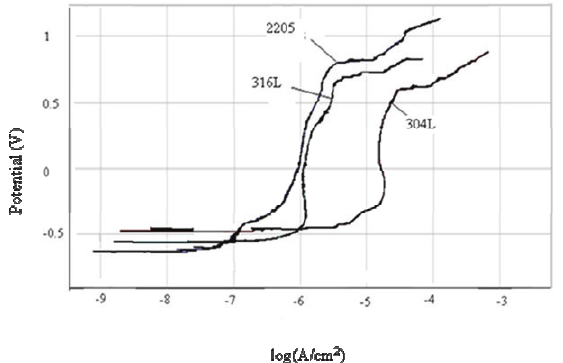
Figure 15. Anodic polarization of stainless steels exposed to inocu- Fig. 15 Anodic polarization of stainless steels exposed to inoculated Baar’s media lated Baar’s media after 10 days incubation after 10 days incubation period